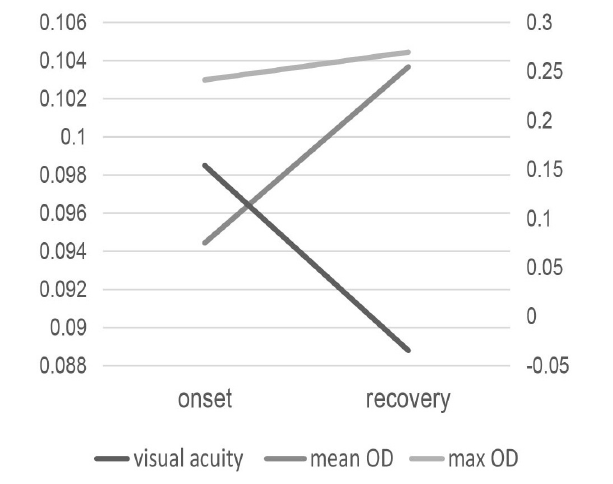
FIGURE 1 | The change of MPOD values and visual acuity in the 9 patients with subretinal fluid absorbed at disease onset and recovery.